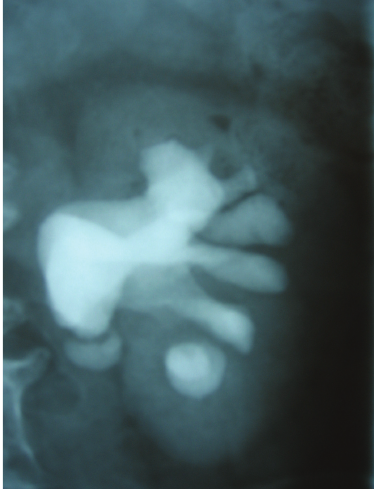
Figure 1: Intravenous urogram demonstrating dilatation of the left PC system with blunting and fullness of the calyces. There is an unusual crescentic shape enhancement seen inferiorly at the left renal pelvis.